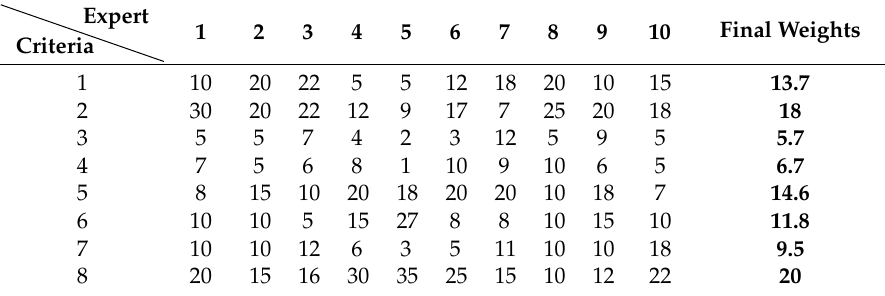
Table 7. Weights elicited from experts,